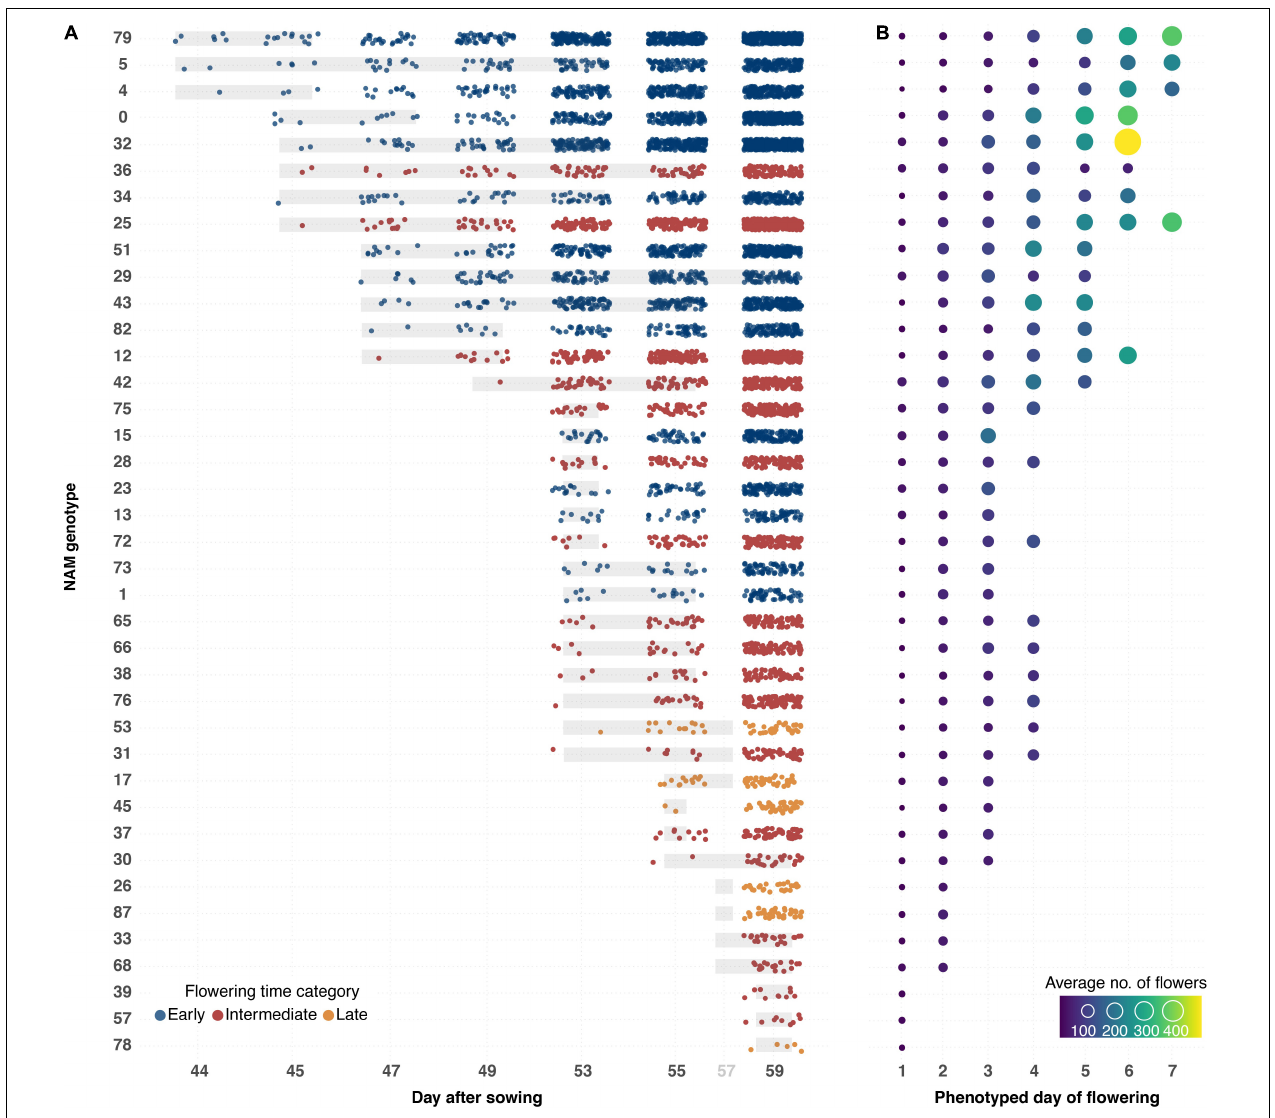
FIGURE 8 | Flowering phenology and intensity for 50 B. napus genotypes ranked by date of anthesis and flower output. (A) Flowering onset and intensity of B. napus genotypes that flowered during the LemnaTec experiment. Dots represent average estimated number of flowers recorded from three individuals (control group) of each genotype. The dots are colored according to previous greenhouse observations of flowering time. Underlying gray bars represent variation in flowering onset. (B) Flowering intensity per phenotyped day of flowering. Sizes and colors of circles represent average number of flowers recorded from three individuals (control group) of each genotype. Order of genotypes is shown in left-hand column in (A)